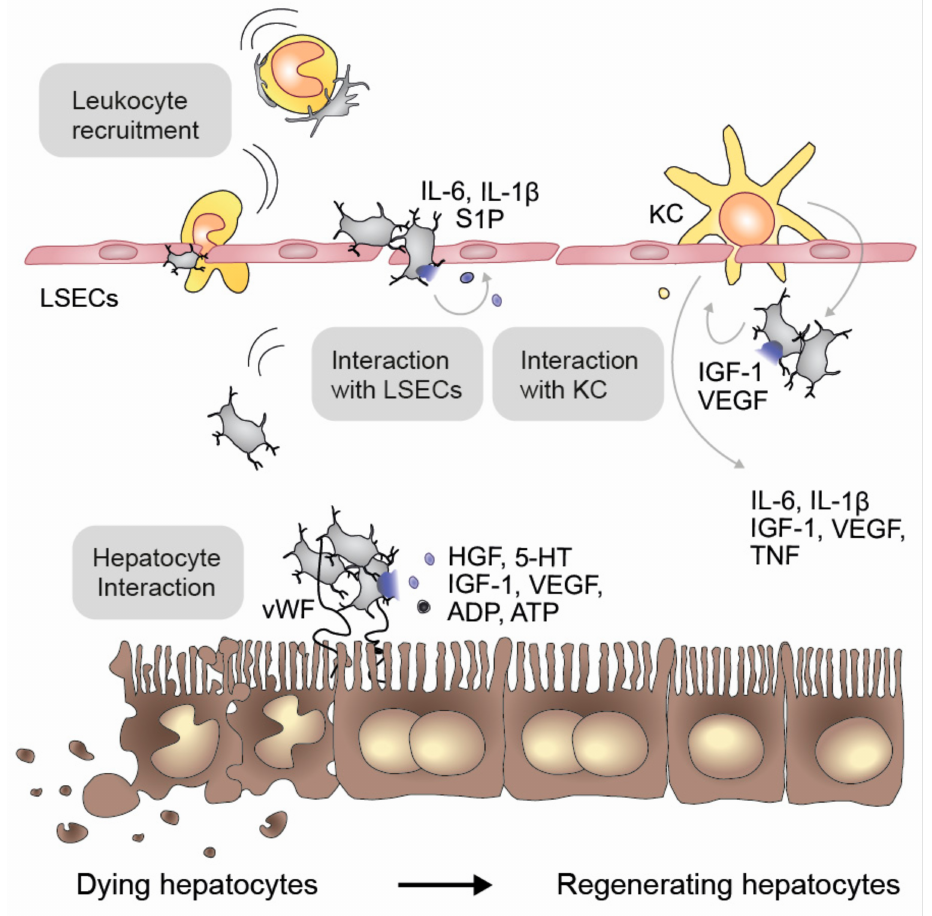
Figure 7. Platelets in liver regeneration. During liver regeneration, activated platelets interact with hepatocytes by binding to the von Willebrand factor (vWF) and by the release of their alpha and dense granule content, which contains hepatic growth factor, serotonin (5-HT), insulin growth factor-1 (IGF-1), vascular endothelial growth factor (VEGF) as well as adenosine diphosphate (ADP) and triphosphate (ATP). Due to the interaction of platelets with liver sinusoidal endothelial cells (LSECs) and the subsequent release of soluble mediators, leukocytes are recruited into the Space of Disse, where they act in concert with Kupffer cells (KC) to modulate liver regeneration. The following mediators are involved: interleukin-6 (IL-6), interleukin-1 β (IL-1 β ), sphingosine-1-phosphate (S1P) and tumor necrosis factor